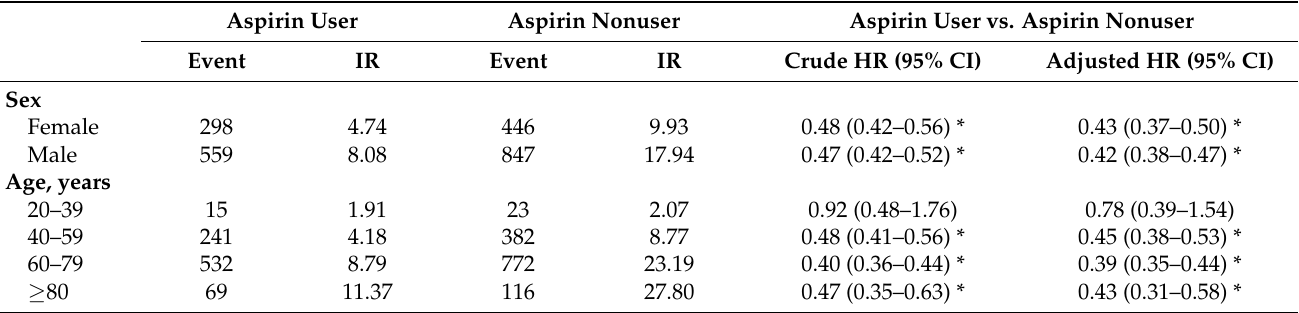
Table 3. Incidence rate and risk of developing primary cancer in ICCD survivors stratified by sex and age.